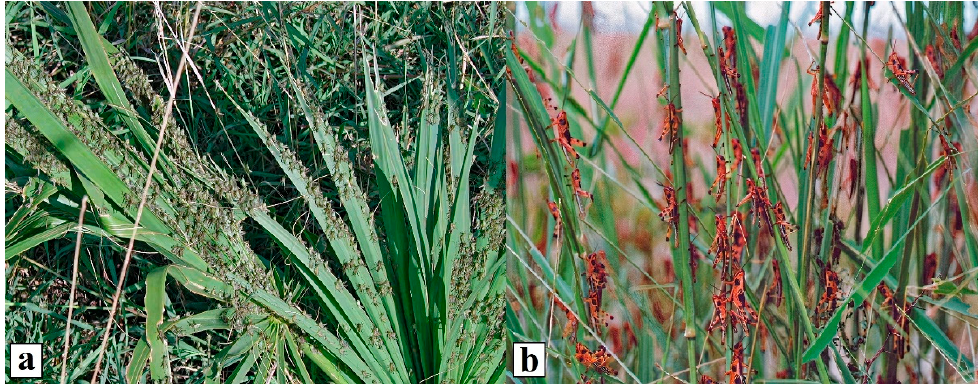
Figure 3. Central American locust, Schistocerca piceifrons piceifrons (Walker, 1870), 1st ( a ) and 6th ( b ) instar bands.